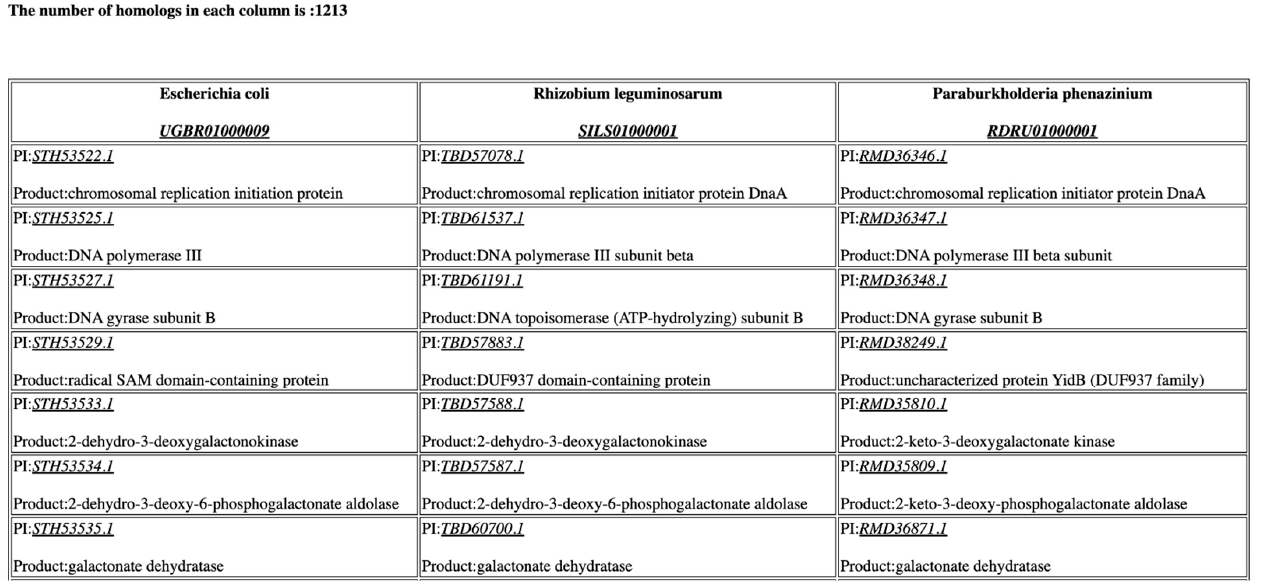
Figure 3. Partial CoreGenes output from three bacterial genomes approximately 5 Mb in size. The links to the complete genomes and individual proteins are shown. As noted, the number of core genes identified is 1213.